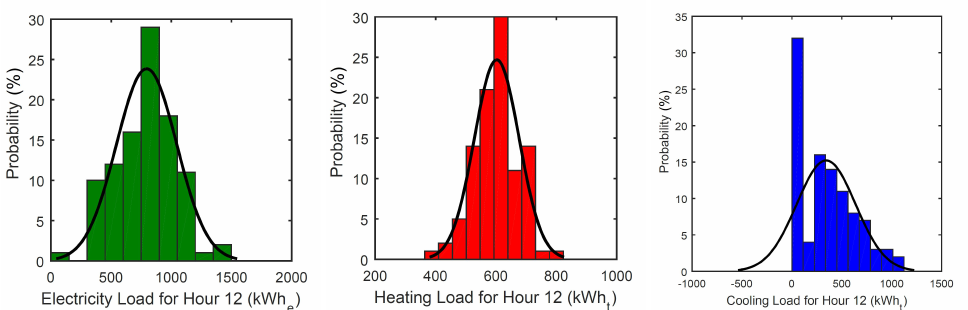
Figure 19. Probability of electricity load ( left ), heating ( center ), and cooling load ( right ) of the 12th hour on 22